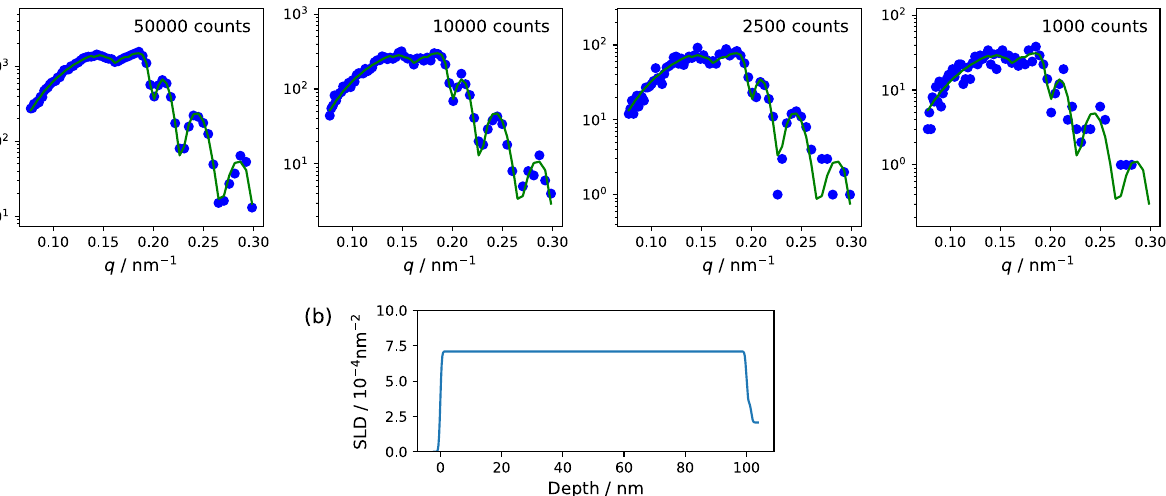
◦ with the total neutron numbers of 50,000, 10,000, − 4 nm − 2 .